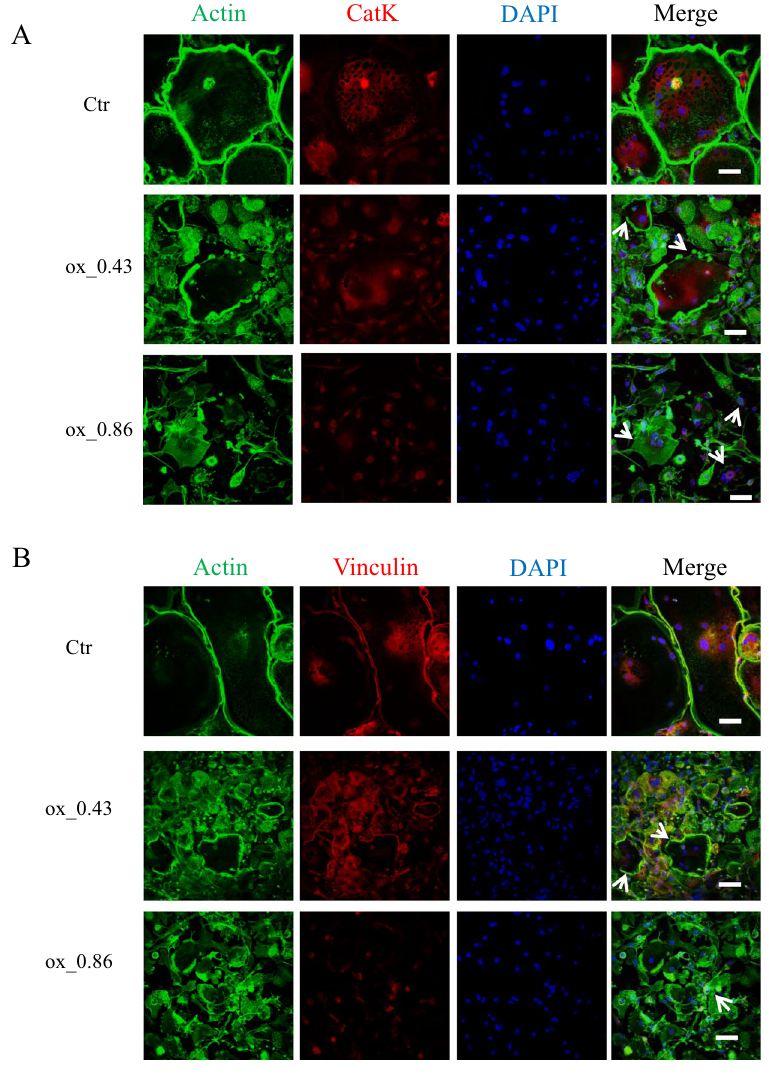
Figure 2. oxLDL inhibits the cytoskeletal rearrangement of osteoclasts. Monocytes plated on glass coverslips were grown in the presence of M-CSF and RANKL for a total of 15 days and cells were analyzed by confocal microscopy. ( A ) Mature osteoclasts were stained FITC-phalloidin (green) and with antibody against CatK (red) and nuclei (DAPI, blue). White arrows indicate disrupted cytoskeleton. ( B ) Mature osteoclasts were stained FITC-phalloidin (green) and with antibody against vinculin (red) and nuclei (DAPI, blue). White arrows indicate disrupted actin binding. Magnification x40, scale bar 50 µ m. n ≥